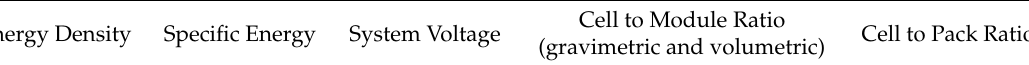
Table A2. Estimated and calculated values.